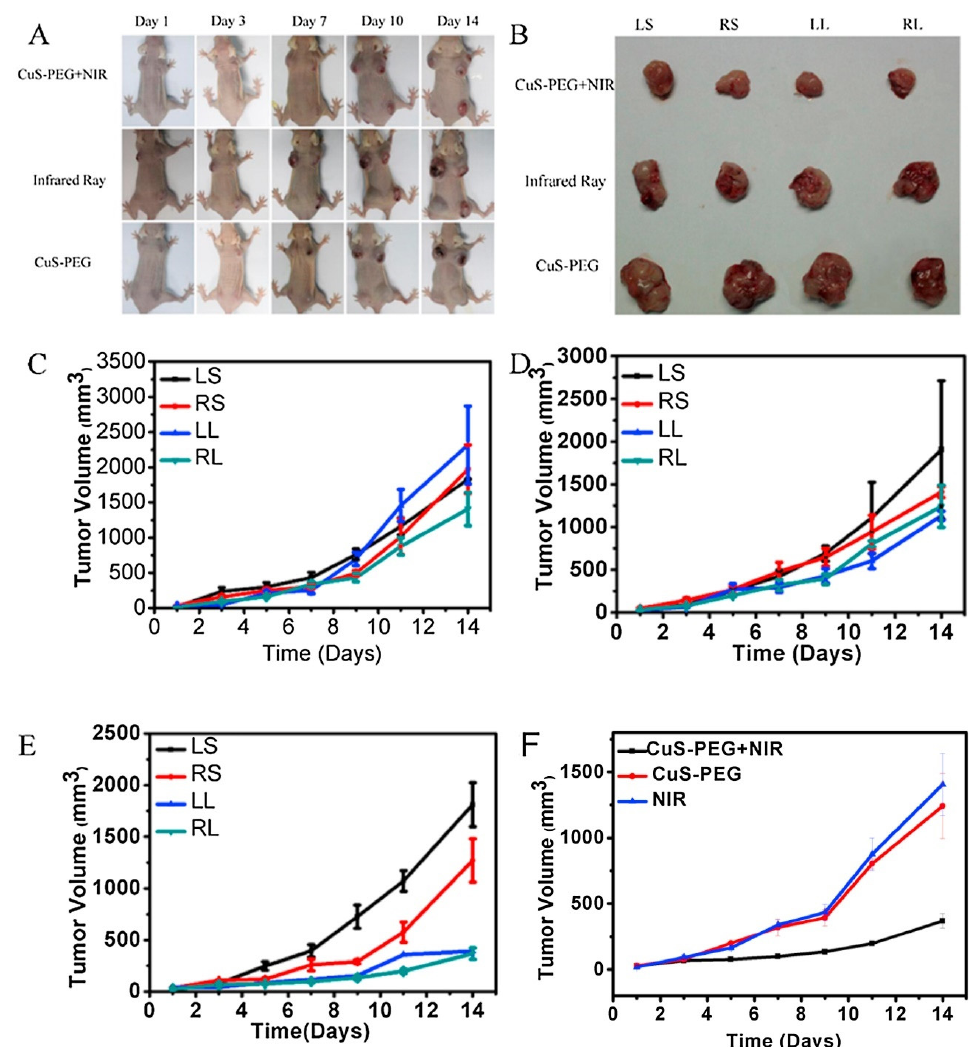
Figure 4. Photos of the tumor ‐ bearing mice at 1, 3, 7, 10 and 14 days ( A ) and SPC ‐ A ‐ 1 tumors at day 14 ( B ) after the treatment of the nanomaterials. Tumor growth curves in the control group; 0 μ L CuS ‐ PEG in LS, 30 μ L CuS ‐ PEG in the RS, 50 μ L of CuS ‐ PEG in the LL, and 100 μ L CuS ‐ PEG in the RL ( C ). Tumor growth curves in the NIR—irradiated group; 0 μ L NS in the LS, 30 μ L NS in the RS, 50 μ L NS in the LL, and 100 μ L NS CuS ‐ PEG in the RL ( D ). Tumor growth curves in the CuS ‐ PEG + NIR group, 100 μ L NS in the LS, 30 μ L CuS ‐ PEG in the RS, 50 μ L CuS ‐ PEG in the LL, and 100 μ L CuS ‐ PEG in the RL ( E ). Tumor growth volume curve comparison for 100 μ L (30 μ g/mL) CuS ‐ PEG +NIR in the RL; 100 μ L (30 μ g/mL) CuS ‐ PEG in the RL, and 100 μ L NS in the RL ( F ). LS—left shoulder administration; RS—right shoulder administration; LL—left leg administration; RL—right leg administration; NS—normal saline solution. Reprinted with permission from [111]. Copyright (2017) Elsevier.